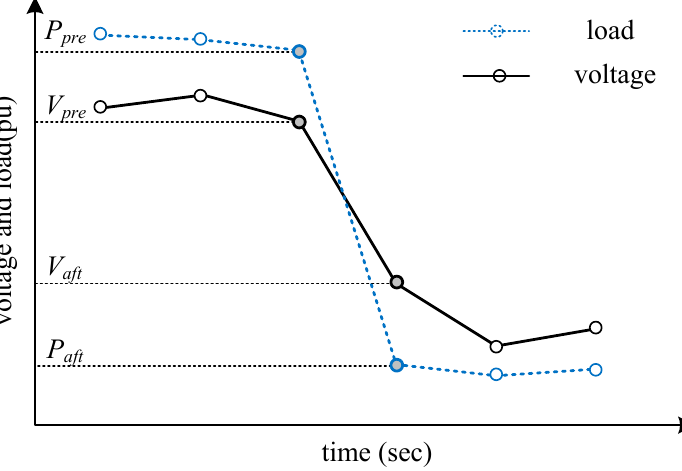
Figure 1. Voltage and load before and after changing the taps.